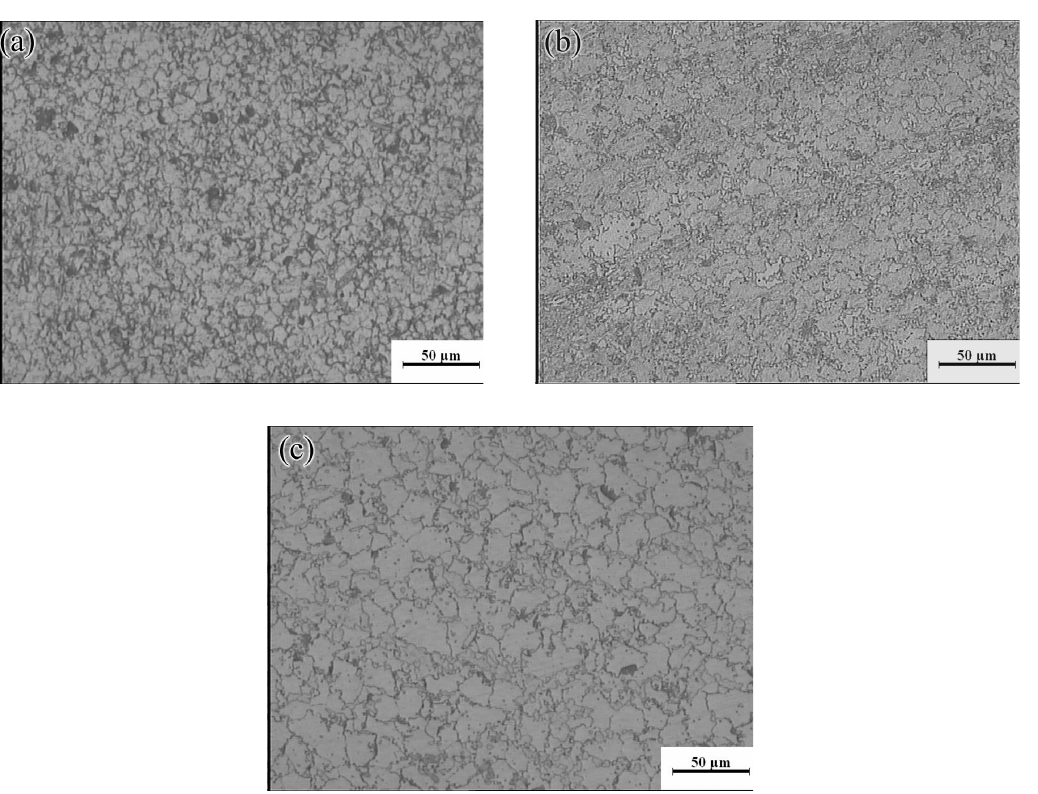
Figure 17. Microstructures of the Mg-16Al Mg alloy in Domain I: ( a ) 673 K / 0 0.1 s − 1 , ( b ) 673 K / 0 0.01 s − 1 , and ( c ) 673 K / 0 0.001 s − 1 .